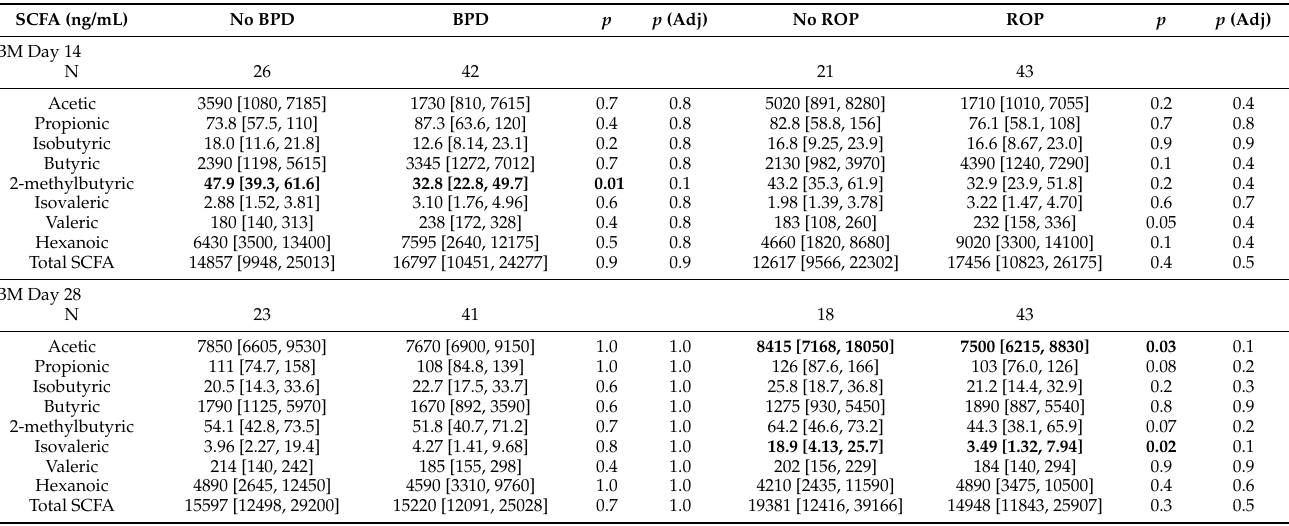
Table 3. Comparison of short-chain fatty acid levels in maternal breastmilk on day 14 and day 28 after delivery based on neonatal comorbidities 1